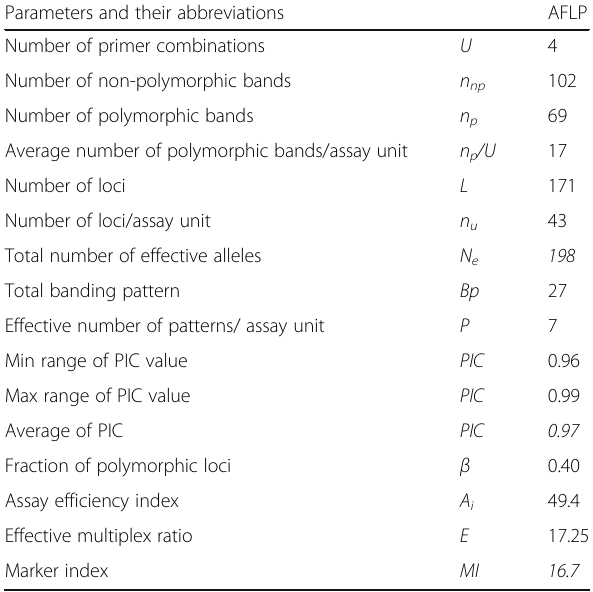
Table 5 The PIC value and other information obtained from AFLP using four primer combinations for Thymus